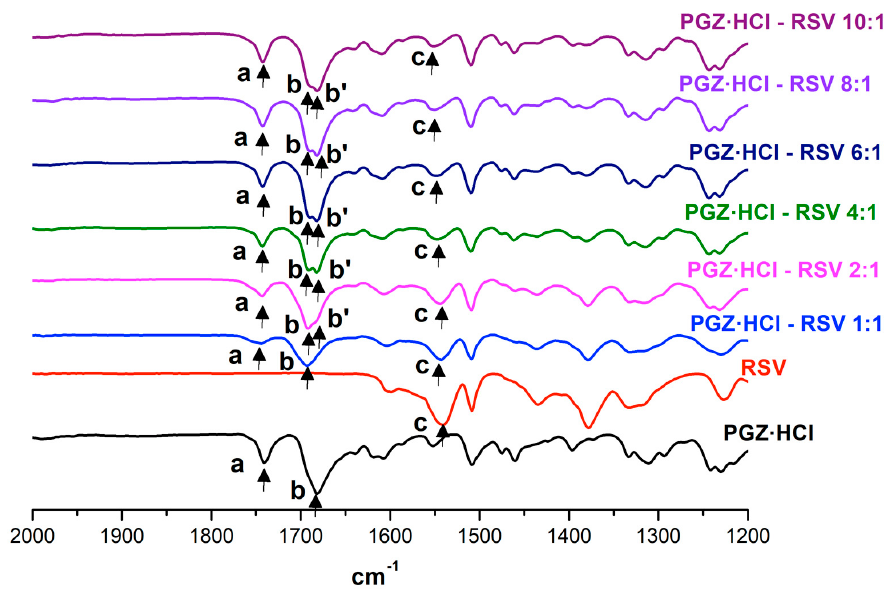
Figure 10. Expanded FT-IR spectra of the solid forms of PGZ · HCl-RSV at different stoichiometric ratios (1:1, 2:1, 4:1, 6:1, 8:1, and 10:1). Table 6. Vibrational band assignment of the solid forms of PGZ · HCl-RSV at different stoichiometric ratios (4:1, 6:1, 8:1, and